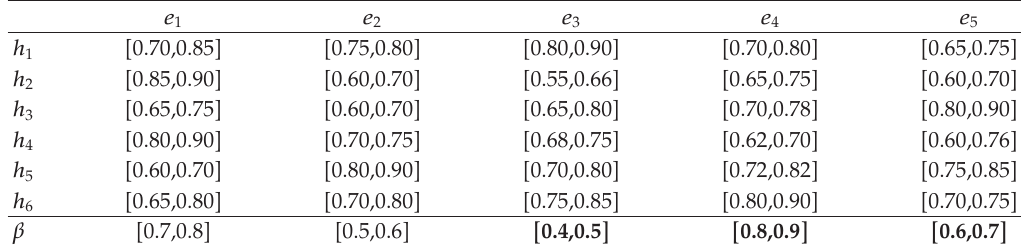
Table 4: Tabular representation of the GIVFS set (cid:2) G β .